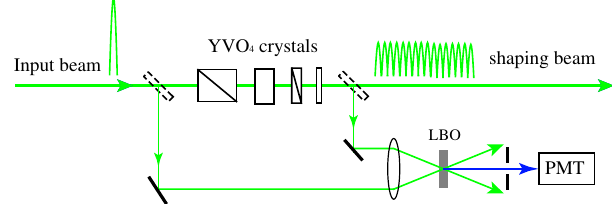
FIG. 13. Laser beam shaping and cross-correlation measure- ment. Four crystals are alternatively oriented at 45 degrees and 0 degrees to achieve the longitudinal shaping and a cross correlator is used to measure the pulse duration.